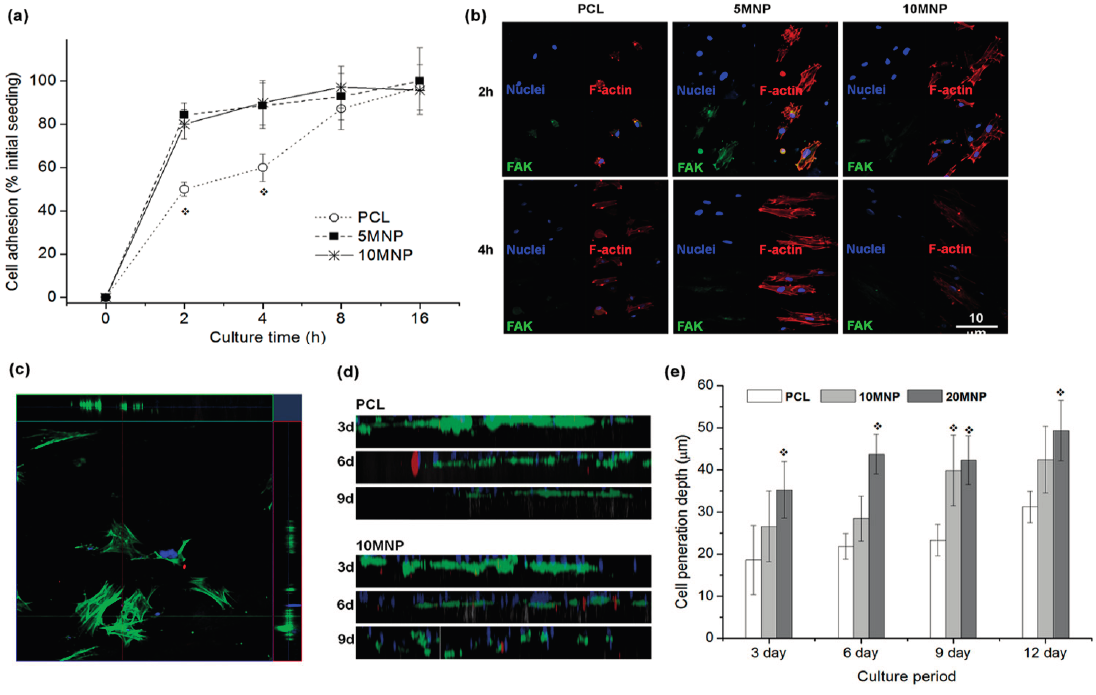
Figure 3. MC3T3-E1 cell adhesion and penetration tests on the nanofiber scaffolds. ( a ) Initial cell adhesion level on the nanofiber scaffolds during culture for up to 16